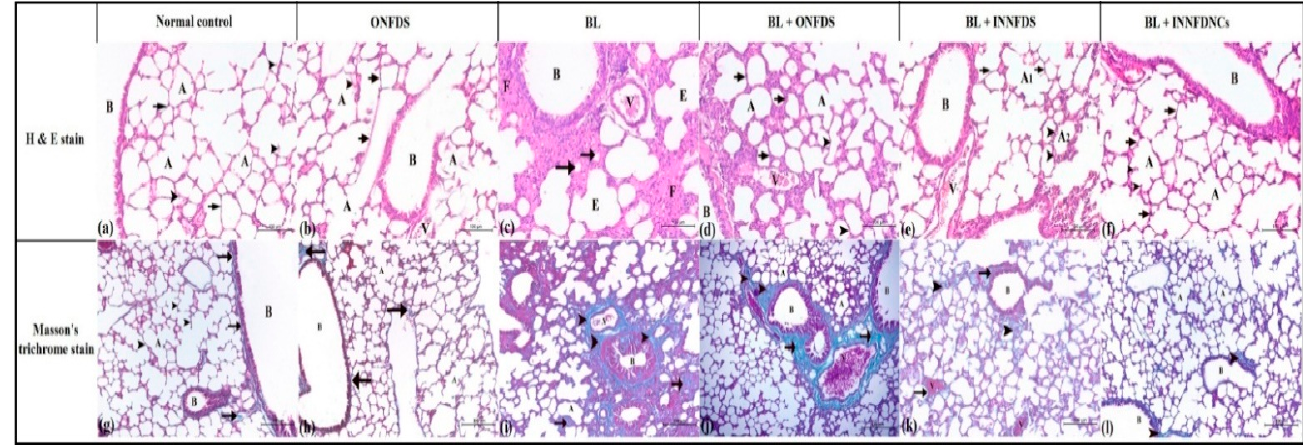
Figure 7. Histopathological features of lung tissues from all groups after three weeks of treatment. ( a – f ): lung tissues stained with hematoxylin and eosin (H & E). Magnification × 100. ( a )—normal control group showed normal pulmonary tissues with normal bronchus and bronchiole (B). The lung alveoli (A) appeared normal with normal and thin alveolar epithelium and inter-alveolar septum (arrow). The alveoli, containing alveolar macrophages (arrow heads). ( b )—oral NFD suspension-treated group showed normal pulmonary tissues with normal bronchus and bronchiole (B). The lung alveoli (A) appeared normal with normal and thin alveolar epithelium and inter-alveolar septum (arrow). The alveoli, containing alveolar macrophages (arrow-heads). ( c )—bleomycin group showed degenerative changes in the epithelial lining of bronchioles (B) and alveoli (A). The alveoli in the lung showed atelectatic (atrophied) alveoli (arrow) and the others suffered from emphysematous changes (E). Note, thickening of the inter-alveolar septum (F) and congestion of the pulmonary blood vessels (V). ( d )—oral NFD suspension + bleomycin group showed few degenerative changes in the epithelial lining of bronchioles (B) and alveoli (A). The majority of the inter-alveolar septum suffered from thickening (arrow), while few septum appeared normal (arrow-heads). The pulmonary blood vessels showed congestion (V). ( e )—inhaled NFD suspension + bleomycin group showed few degenerative changes in the lining of the epithelium of bronchioles (B). The majorities of the alveoli (A1) appeared normal with normal and thin inter-alveolar septum (arrow). Few alveoli (A2) suffered from degenerative changes and thickening of the alveolar wall (arrow-head). The pulmonary blood vessels showed a minimal degree of congestion (V). ( f )—inhaled NFD nanocomposites + bleomycin group showed normal pulmonary tissues with normal bronchus and bronchiole (B). The lung alveoli (A) appeared normal with normal and thin alveolar epithelium and inter-alveolar septum (arrow). The alveoli containing alveolar macrophages (arrow-heads). ( g – l ): lung tissues stained with Masson’s trichrome. Magnification × 100. ( g )—normal control group showed normal pulmonary tissues with fine collagenic fibers around the bronchioles and blood vessels (arrow). The inter-alveolar septum (arrow head) around alveoli (A) appeared free from any collagen fibers. ( h )—Oral NFD suspension-treated group showed normal pulmonary tissues with fine collagenic fibers around the bronchioles and blood vessels (arrow). The inter-alveolar septum (arrow head) around alveoli (A) appeared free from any collagen fibers. ( i )—bleomycin group showed proliferative collagenic bundles around bronchioles (B) and blood vessels (V) (arrow-head). The inter-alveolar septum around the alveoli (A) contained thick collagen bundles (arrow). ( j )—oral NFD suspension + bleomycin group showed proliferative collagenic bundles around bronchioles (B) and blood vessels (V) (arrow). The inter-alveolar septum around few alveoli (A) contained thick collagen bundles (arrow head) while the others appeared normal. ( k )—inhaled NFD suspension + bleomycin group showed proliferative collagenic bundles around bronchioles (B) and blood vessels (V) (arrow). The inter-alveolar septum around few alveoli (A) contained fine collagen fibers (arrow-head) while the majority of alveoli appeared normal. ( l )—inhaled NFD nanocomposites + bleomycin group showed normal pulmonary tissues with fine collagenic fibers around the bronchioles and blood vessels (arrow). The inter-alveolar septum (arrow-head) around alveoli (A) appeared free from any collagen fibers. ONFDS: oral nifedipine suspension; BL: bleomycin; INNFDS: inhaled nifedipine suspension; INNFDNCs: inhaled nifedipine